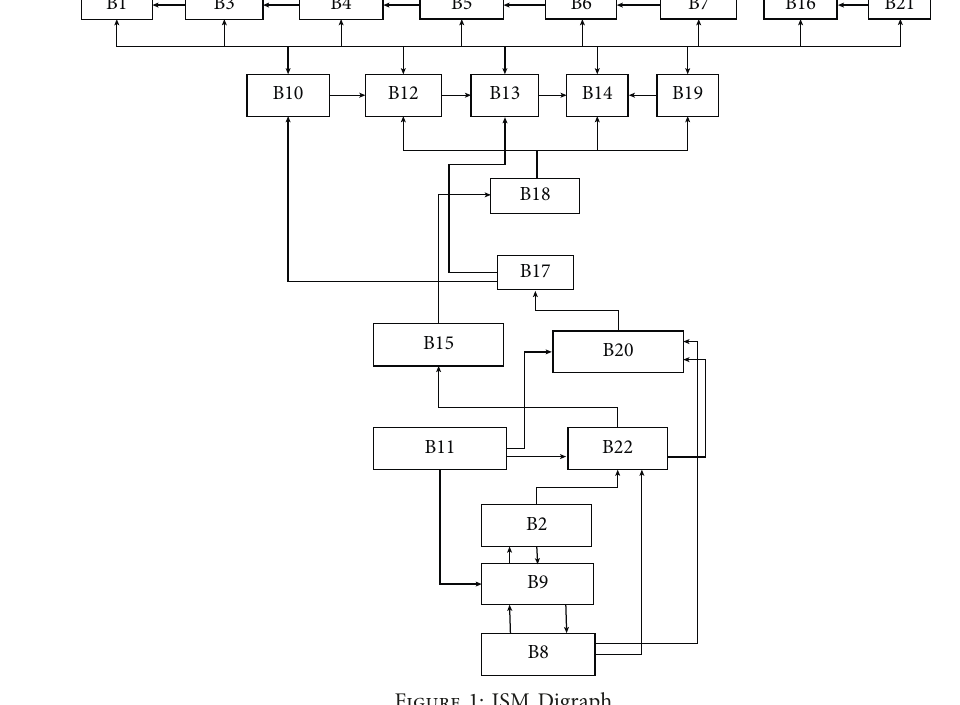
Figure 1: ISM Digraph.